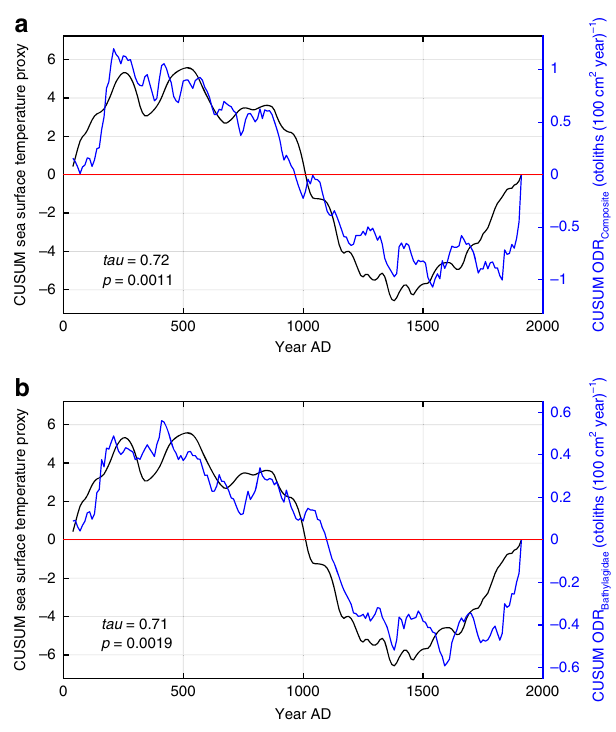
Fig. 5 Cumulative summations of otolith deposition rate and sea surface temperature proxy. a Sea surface temperature (SST) proxy and Composite (all classi fi ed otoliths) otolith deposition rate (ODR). b SST proxy and Bathylagidae ODR. ODR time series detrended before cumulative summation (CUSUM) analysis. Kendall ’ s tau and associated probability ( p ) shown. Probabilities computed using distribution of tau from time series with distributional and autoregressive properties of ODR time series. Time period is 40 – 1910 A.D. with 10-year resolution and n bins = 188. Red line is zero CUSUM. Source data are provided as a Source Data fi